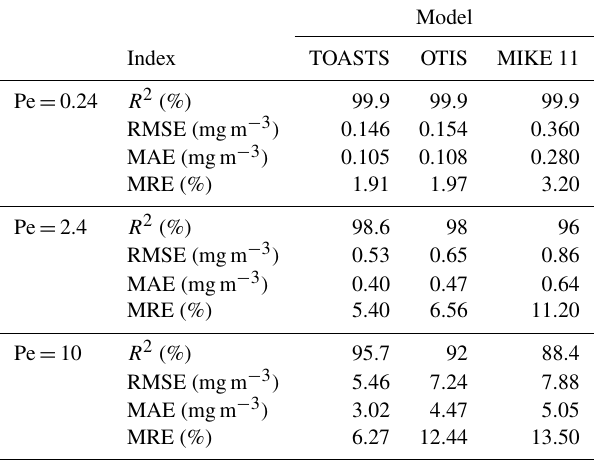
Table 9. Error indices of concentration longitudinal profiles in test case 2.